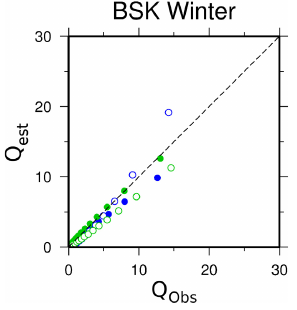
Fig. 6. Combination of methods by first transforming the cumu- lative distribution function and then applying multiple linear re- gression. Blue dots (circles): validation-subset consists of the first (second) half of all winter values. Green dots (circles): validation- subset consists of all winter values with an even (odd) entry